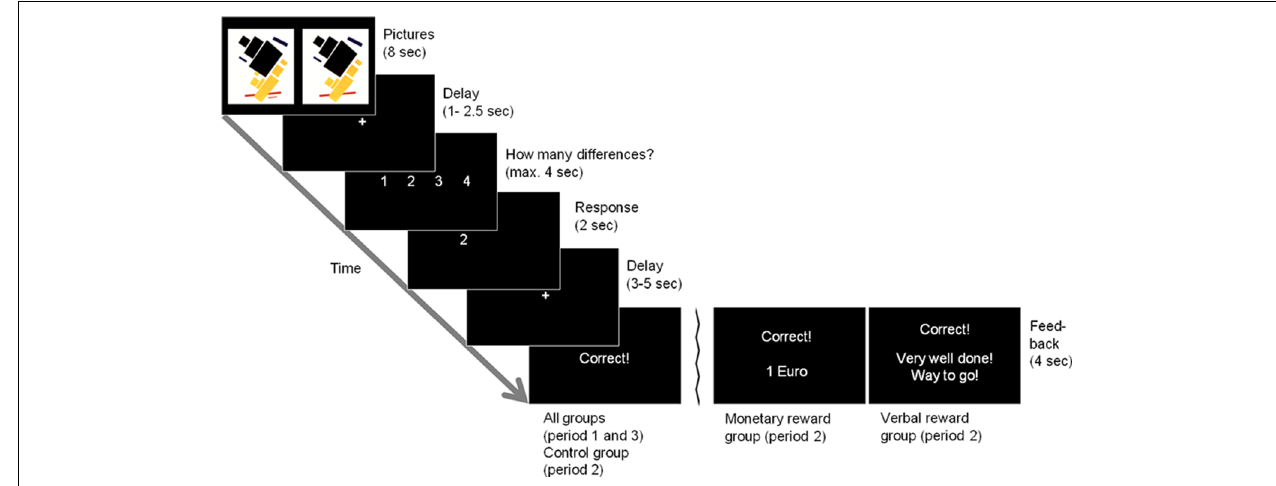
FIGURE 1 | Example trial. Two picture stimuli are presented simultaneously. The subjects have to find the number of differences between the stimuli. There are two differences between the original picture stimulus (top panel, left) and the manipulated version (top panel, right) in this example, in which a red and a black bar are